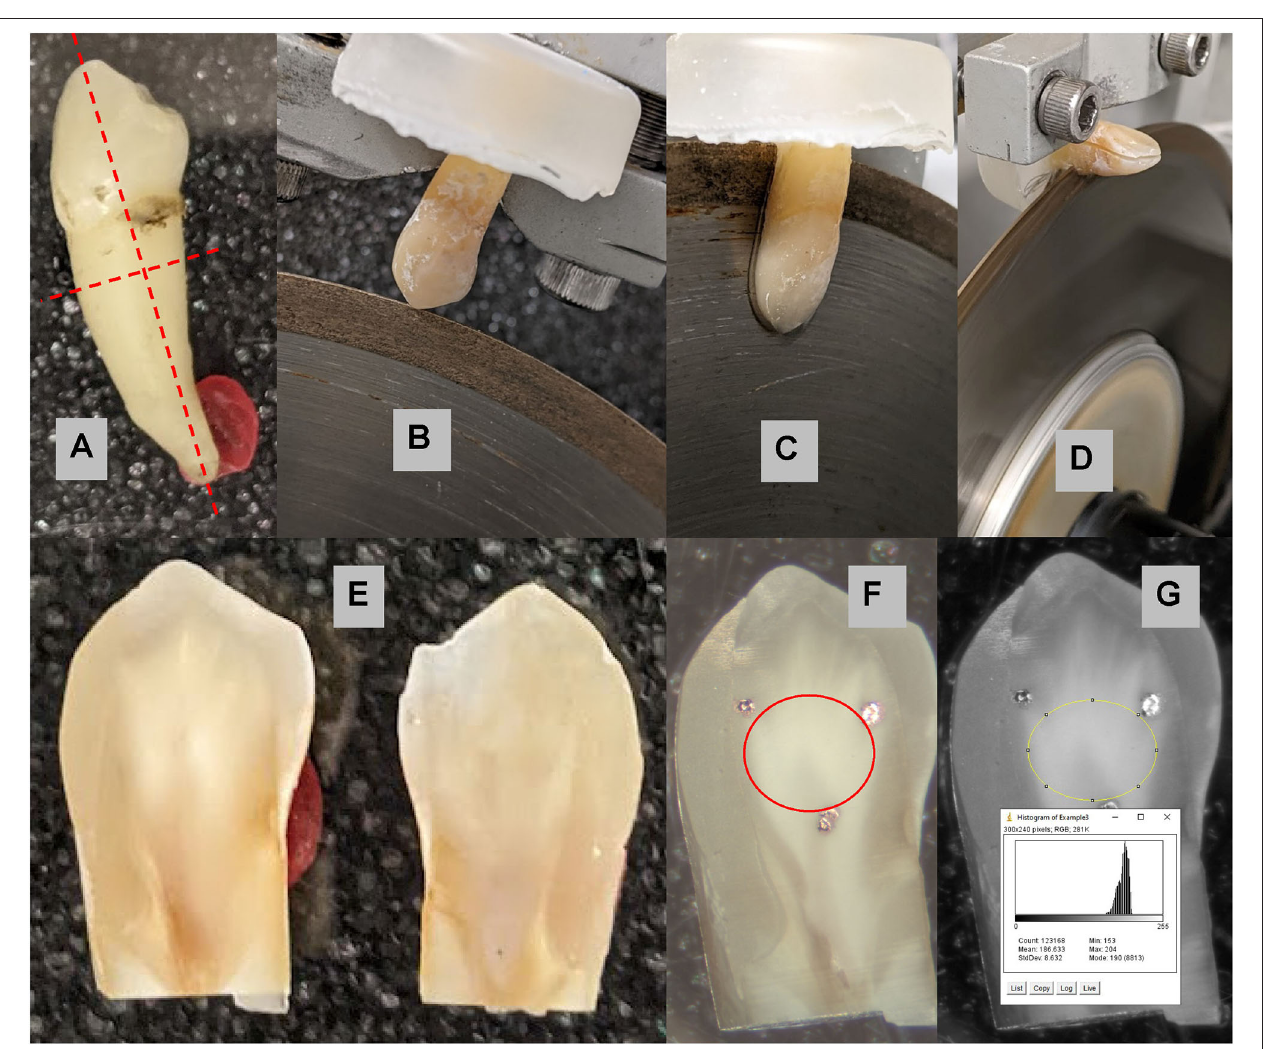
FIGURE 1 | Sample preparation: (A) a non-molar tooth was selected to be bisected and the root removed 2.5–3mm below the dentin-enamel junction as indicated by the red dashed lines. (B) The tooth is mounted on a slow speed water-cooled diamond saw; and (C) bisected through the crown into the root. (D) The root is removed 2.5–3mm below the dentin-enamel junction. (E) Two samples from each tooth are (F) marked with three black dots as fiduciary markers indicating the area of interest for the experiments. The area of the dentin inside of the markers marked in red is analyzed for shade change. (G) The average pixel value within the area of interest was 186.6 ± 8.6 on the 256 grayscale